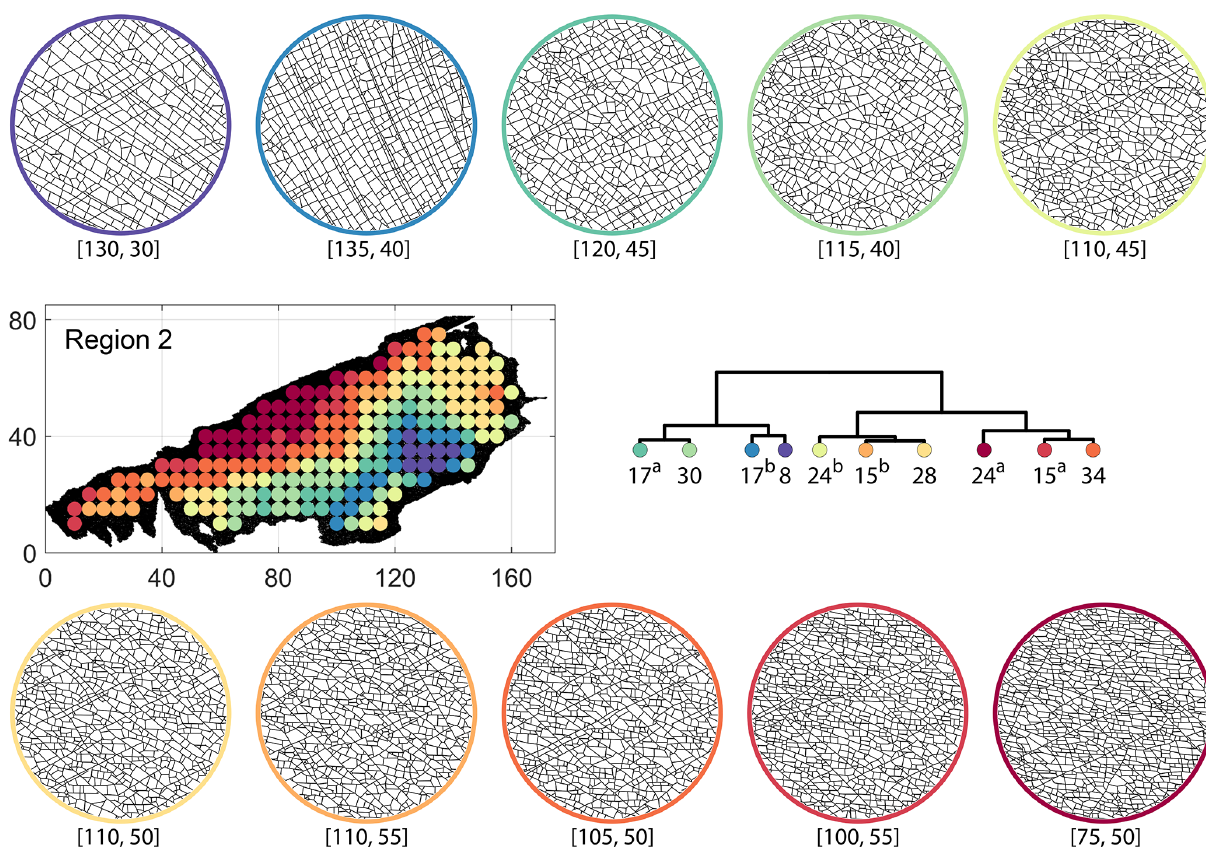
Figure C6. Circular subgraph samples depicting variation in fracturing style as identified in the 10 largest clusters by portrait divergence in Region 2. Coordinates of circular sample centres are below each subgraph